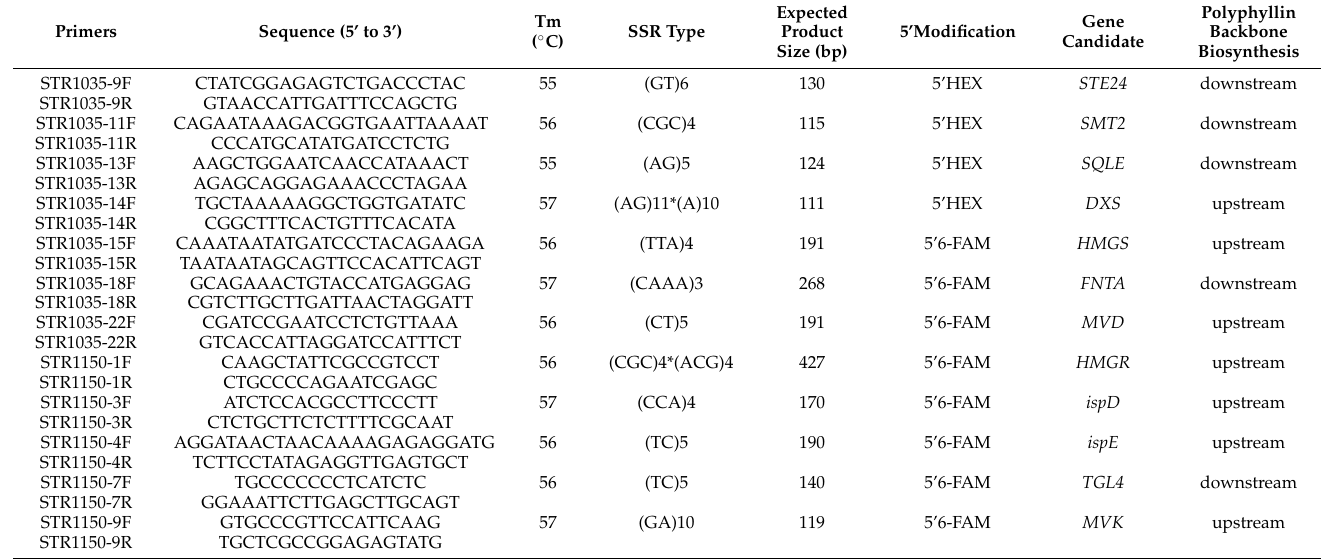
Table 2. Primers associated with polyphyllin biosynthetic gene designed in this study.